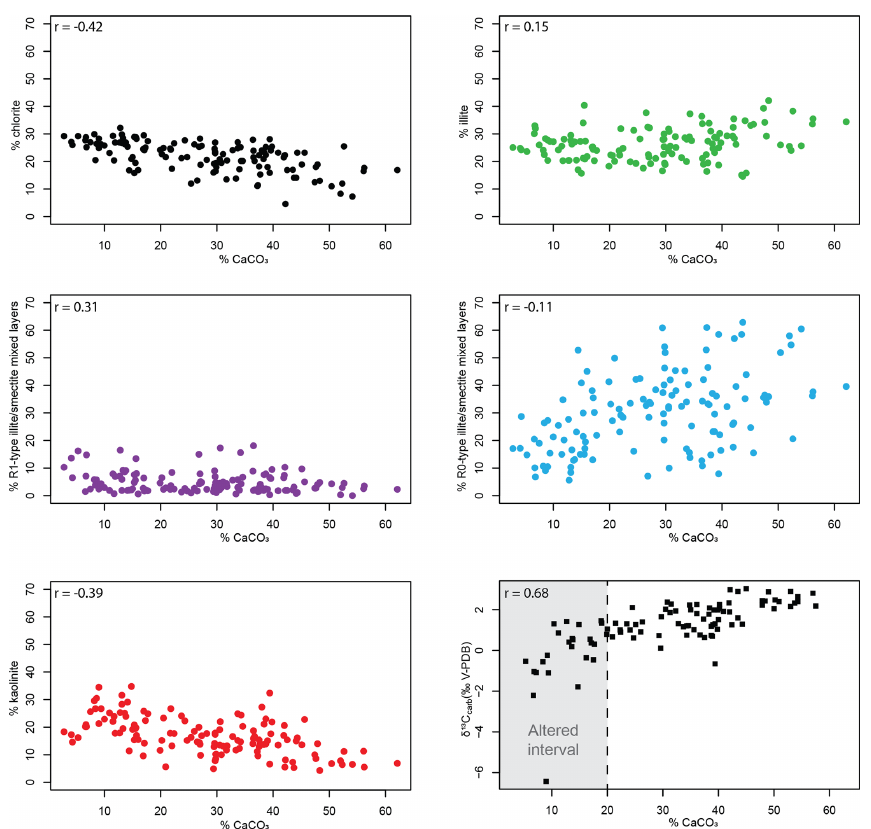
Figure 9. Correlations between CaCO 3 content, the clay mineral relative proportions in the clay fraction, and δ 13 C carb values in the Mochras